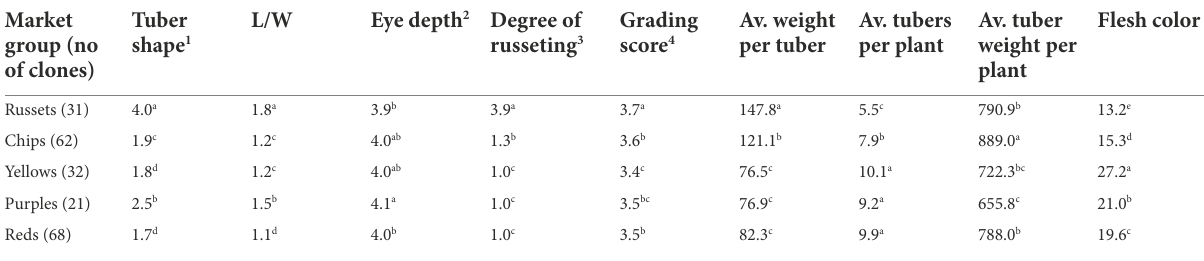
TABLE 2 Mean BLUE values of 214 potatoes (by market group) for tuber morphological traits evaluated in three environments in Texas: Dalhart 2019, 2020, and Springlake 2020. Market group